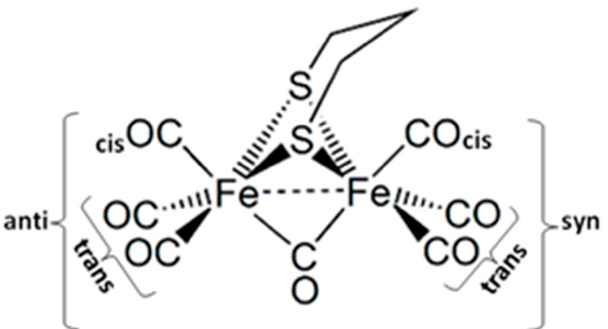
Figure 2. Schematic representation of the [Fe 2 (S 2 C 3 H 6 )(CO) 6 ( µ -CO)] z (z = 0, 1) species analyzed in the present work.